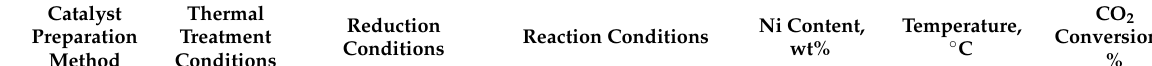
Table 4. Comparison of nickel–alumina catalysts for CO 2 methanation.